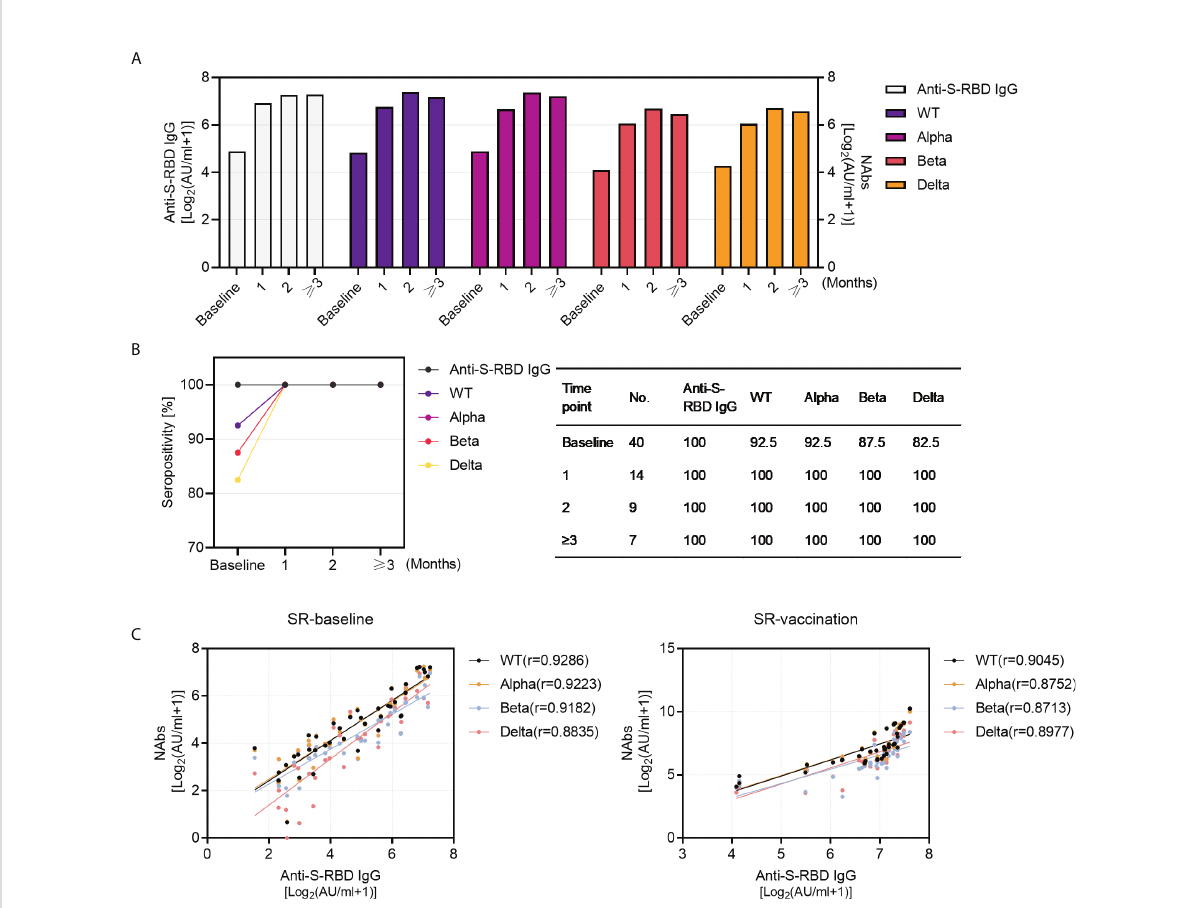
FIGURE 3 Kinetics of antibody responses in SARS-CoV-2 recovered patients with inactivated vaccination and the correlation between anti-S-RBD IgG and NAbs. (A) The dynamics of antibody titers (left Y-axis: anti-S-RBD IgG; right Y-axis: NAbs titers against WT and VOCs) within 3 months in SARS- CoV-2 recovered patients (baseline, N=40; post-vaccination 1 month, N=14, 2 months, N=10, and ≥ 3 months, N=16). (B) Sero-positivity within 3 months in SARS-CoV-2 recovered patients (baseline, N=40; post-vaccination 1 month, N=14, 2 months, N=10,and ≥ 3 months, N=16). (C) The correlation between anti-S-RBD IgG and NAbs pre- (N=40) and post- (N=40) vaccination in SARS-CoV-2 recovered group. Spearman ’ s rank correlation test was used for statistical